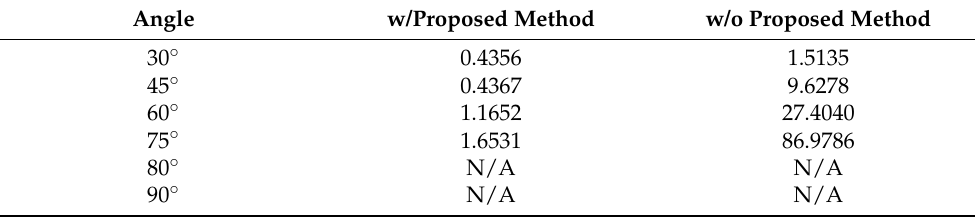
Figure 10. Estimated cable displacement with various angles. Table 2. RMSE of the estimated displacement with various angles.